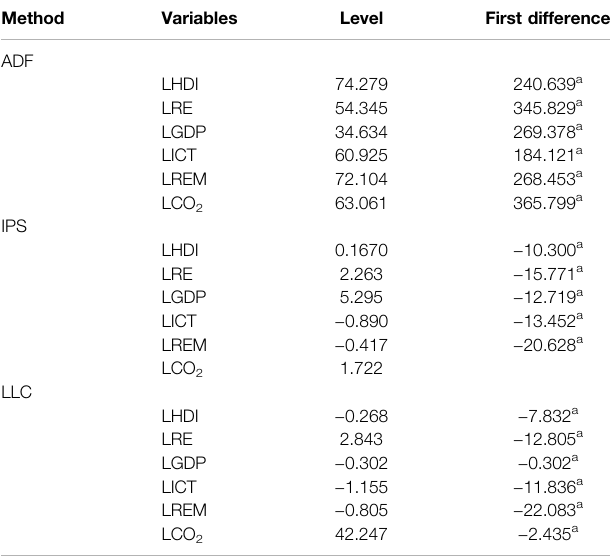
TABLE 3 | Panel unit root test results.